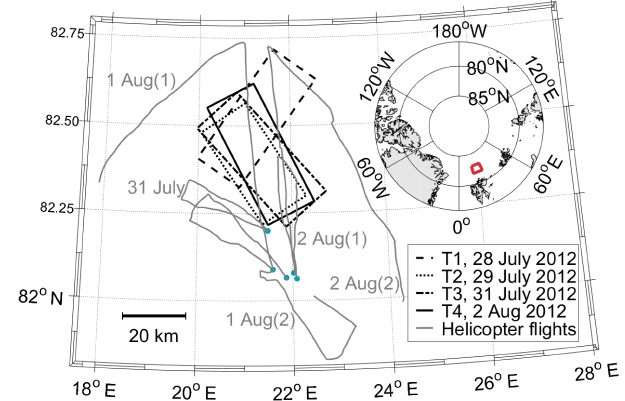
Figure 1. Map of the study area north of Svalbard, showing the location of the satellite scenes and the track of the helicopter flights. Blue dots mark the starting points of the flights. The red box in the inset map of the Northern Hemisphere shows the geographical position of the area